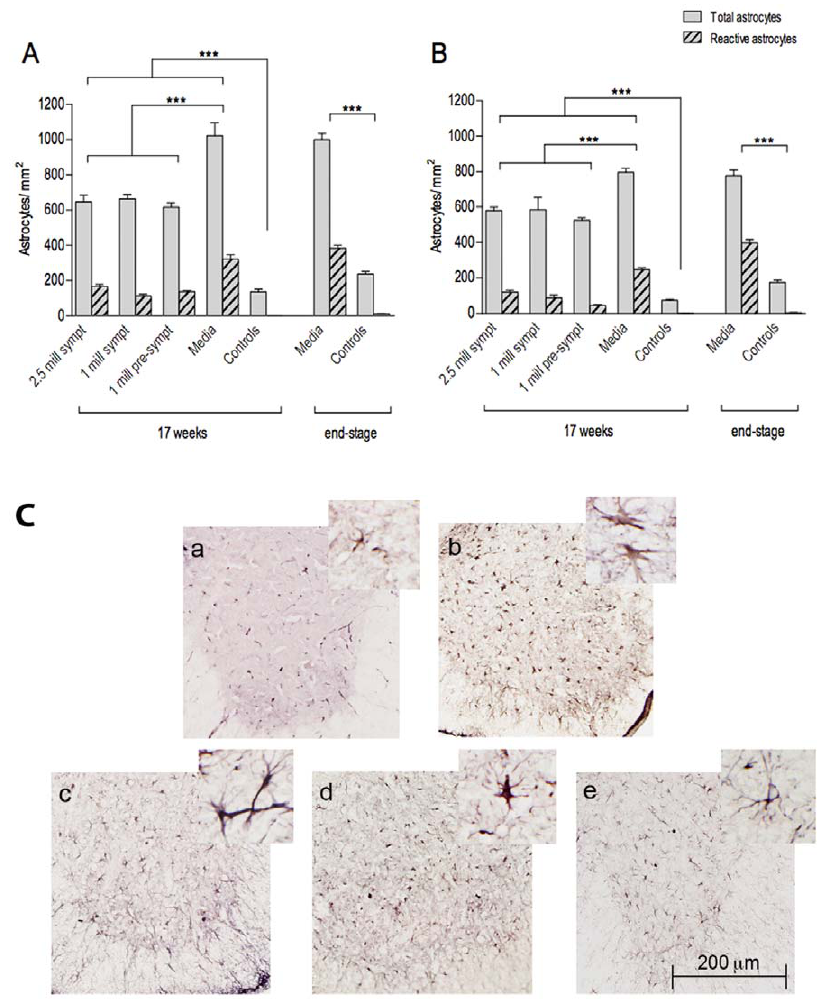
Figure 7. Characteristics of astrocytes in the spinal cord of G93A mice. Astrocyte densities were measured in the cervical ( A ) and lumbar ( B ) ventral horns of G93A mice at 17 weeks of age and at end-stage of disease. Astrocytic densities were significantly (p , 0.001) higher in Media-injected mice ( Gr 4 ) at 17 weeks of age and at end-stage of disease vs. controls ( Gr 5 ) of the same ages. Significant (p , 0.001) decrease in the number of astrocytes was determined in cell-treated G93A mice compared to Media mice. No significant statistical differences were detected between the cell- treated groups. Higher number of reactive astrocytes was observed in Media-injected mice at 17 weeks of age and at end-stage disease compared to cell-treated animals. ***p , 0.001. ( C ) Immunohistochemical staining of astrocytes in the lumbar spinal cord of G93A mice at 17 weeks of age. Anti- GFAP antibody staining showed low astrocyte density in controls ( a ) and astrocytosis in Media-treated animals ( b ). Considerably decreased actrocytic density was observed in mice from Gr 1 ( c ), Gr 2 ( d ), and Gr 3 ( e ). Astrocyte cell reactivity was also reduced in cell-treated mice vs. Media-injected mice (inserts in a–e). Scale bar: a–e is 200 m m; in a–e inserts is 25 m m.